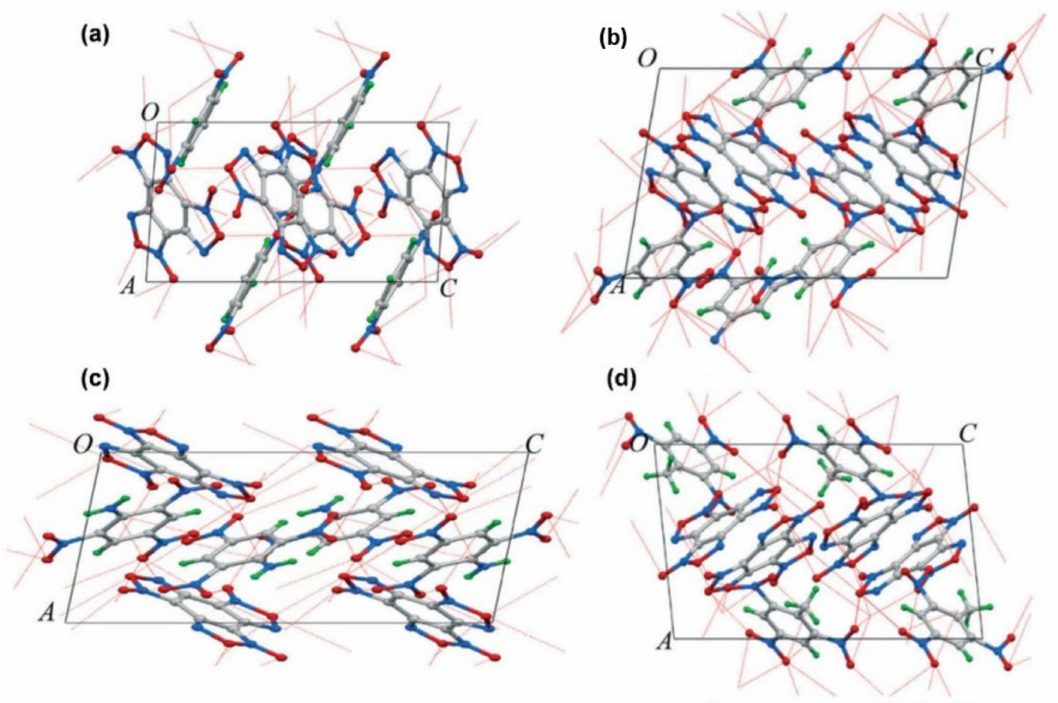
Figure 6. The intermolecular hydrogen bond and N—O · · · NO 2 type interactions between BTF and DNB, TNB, TNA, and TNB molecules in cocrystals. ( a ) BTF/DNB cocrystal, ( b ) BTF/TNB cocrystal, ( c ) BTF/TNA, and ( d ) BTF/TNT, respectively. The lengths of H · · · N, H · · · O, and O · · · N contacts are presented in red dashed lines. Reproduced from reference [61]. Copyright 2015, The Royal Society of